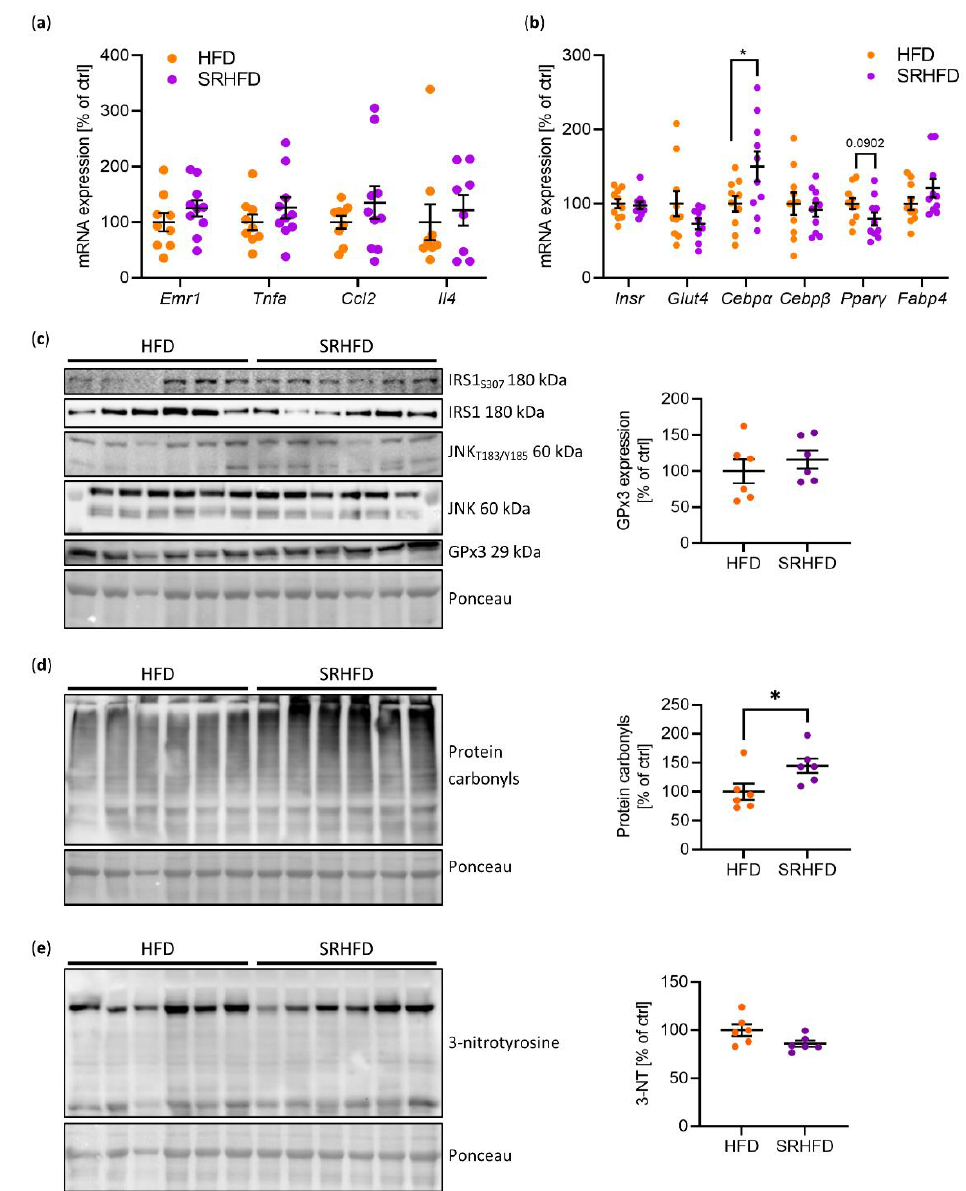
Figure 5. WAT function after selenite treatment in established obesity. ( a ) mRNA expression of inflammatory markers in gWAT of male C57BL/6N mice fed either HFD or SRHFD for 10 weeks after established obesity. ( b ) mRNA expression of adipocyte markers in gWAT of male C57BL/6N mice fed either HFD or SRHFD for 10 weeks after established obesity. ( c ) Protein phosphorylation, expression, and densitometric analysis of insulin resistance markers in gWAT of male C57BL/6N mice fed either HFD or SRHFD for 10 weeks after established obesity. ( d ) Protein carbonylation and densitometric analysis in gWAT of male C57BL/6N mice fed either HFD or SRHFD for 10 weeks after established obesity. ( e ) Protein 3-nitrotyrosine modification and densitometric analysis in gWAT of male C57BL/6N mice fed either HFD or SRHFD for 10 weeks after established obesity. *: p < 0.05 after two-tailed Student’s t -test. All data are presented as mean ±